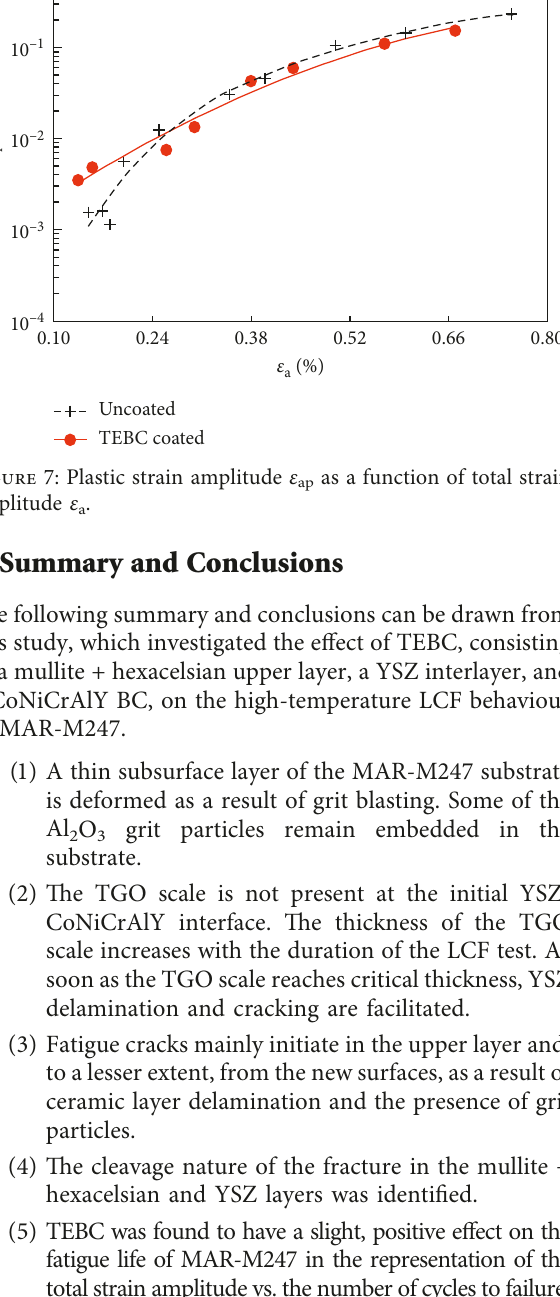
ap as a function of total strain